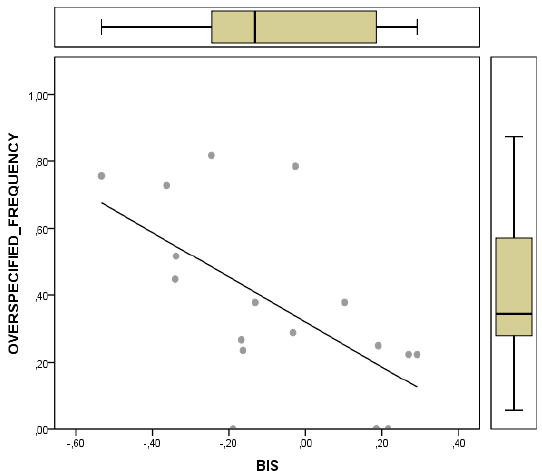
Figure 2. Dispersion graph between BIS and the normalized frequency of overspecified forms (overt pronouns and full noun phrases). Table 7. Cases of clitic omission occurring in the narratives. The first column indicates the subject that produced the sentence, the second her BIS, and the fourth the type of structure in which the clitic is missing or the type of clitic that is